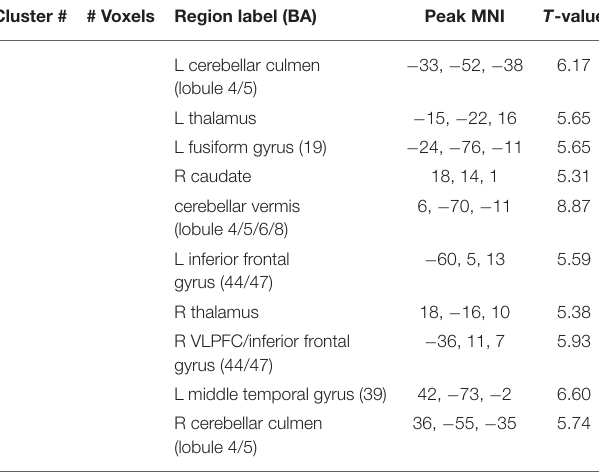
TABLE 1 | Peak MNI coordinates, t -values, and region labels for the antisaccade > baseline whole brain contrast, averaged over session. Cluster # # Voxels Region label